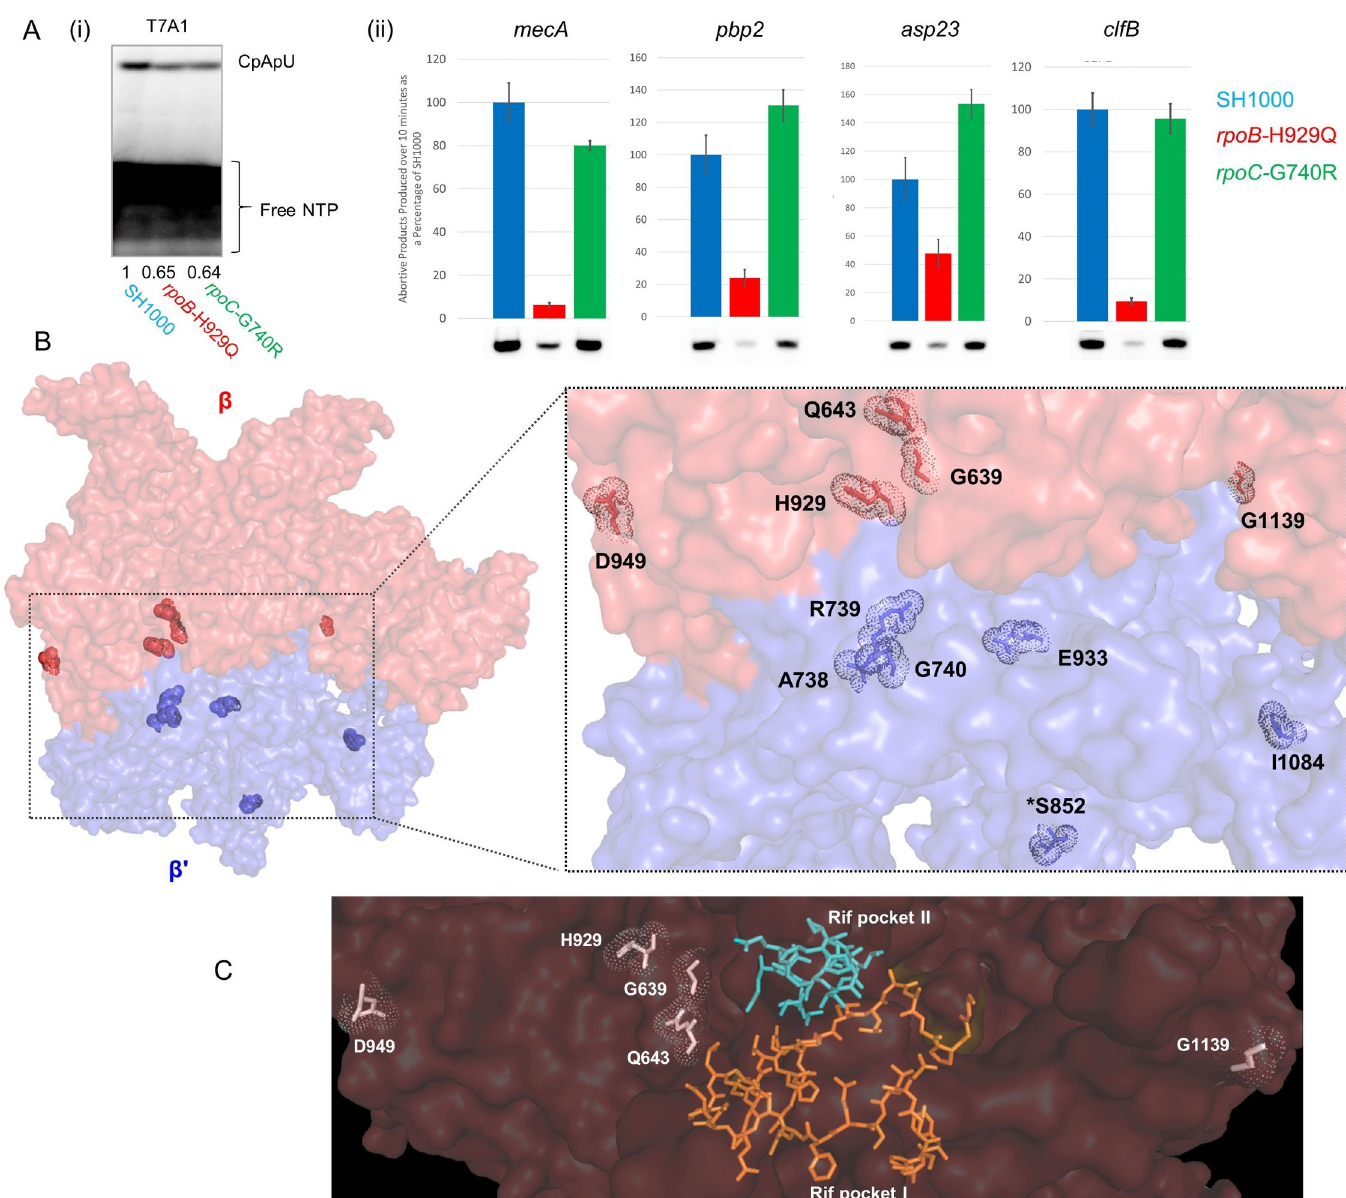
Fig 3. Location of rpoB/C mutations and the impact on transcription initiation. A) (i) Abortive products produced on the T7A1 promoter by S . aureus RNAPs over 10 min at 37˚C. (ii) Abortive initiation by SH1000, lysA ::p mecA rpoB- H929Q (SJF5003) and lysA ::p mecA rpoC- G740R (SJF5034) holoenzymes on the promoters of mecA , pbp2 , asp23 and clfB . Abortive products were normalised to abortive synthesis on T7A1 promoter. Error bars show ± SD from three replicates. B) The three-dimensional structure of E . coli RNAP holoenzyme was used to map the rpoB and rpoC mutations [67]. The two subunits β (red) and β ’ (blue) are shown as molecular surface. The mutated residues of rpoB/C ( S . aureus residue numbering) are highlighted with dots (Zoomed in section). � , residue not conserved in E . coli . C) S . aureus rpoB mutations mapped on the structure of E . coli RpoB shows relative location of the mutations to the rifampicin binding pocket regions l and ll [47], shown as orange and cyan sticks, respectively. Figure generated from PDB 6CUX using